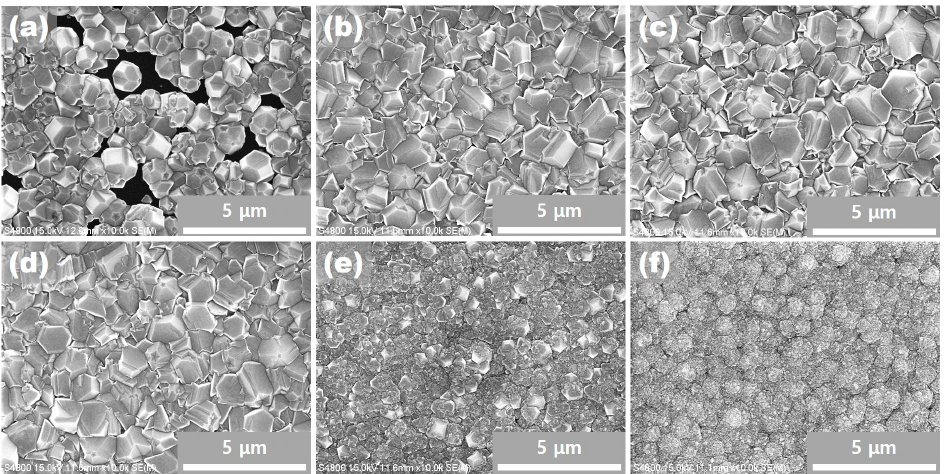
Figure 2. FE–SEM images of diamond films deposited at acetone fluxes of ( a ) 80, ( b ) 90, ( c ) 130, ( d ) 170, ( e ) 210, and ( f ) 250 standard cubic centimeters per min (sccm), with the respective hydrogen fluxes as shown in Table 1.